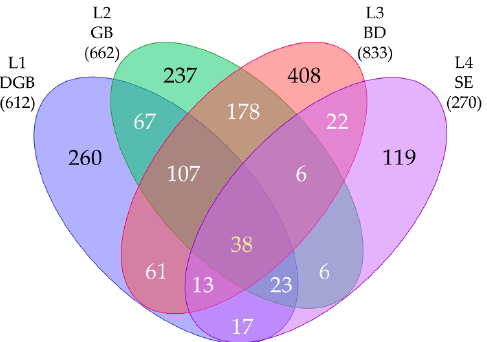
Figure 3. Venn diagram analysis of shared OTUs between samples.